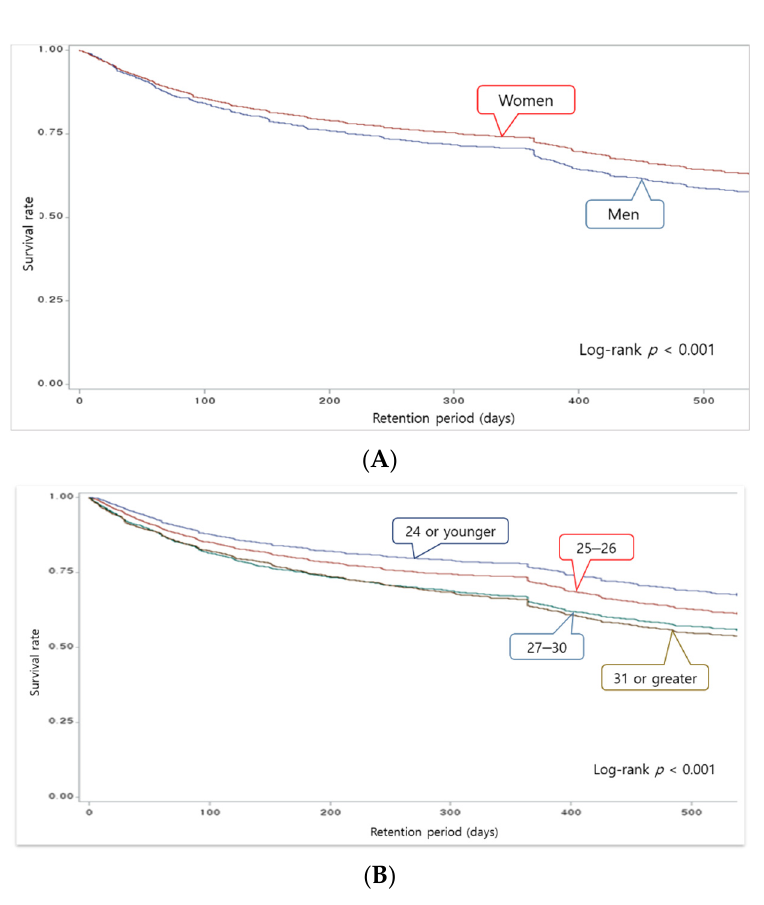
Figure 2. Survival curves by nurses’ characteristics. ( A ) Comparison of the likelihood of remaining at work by gender. ( B ) Comparison of the likelihood of remaining at work by age.